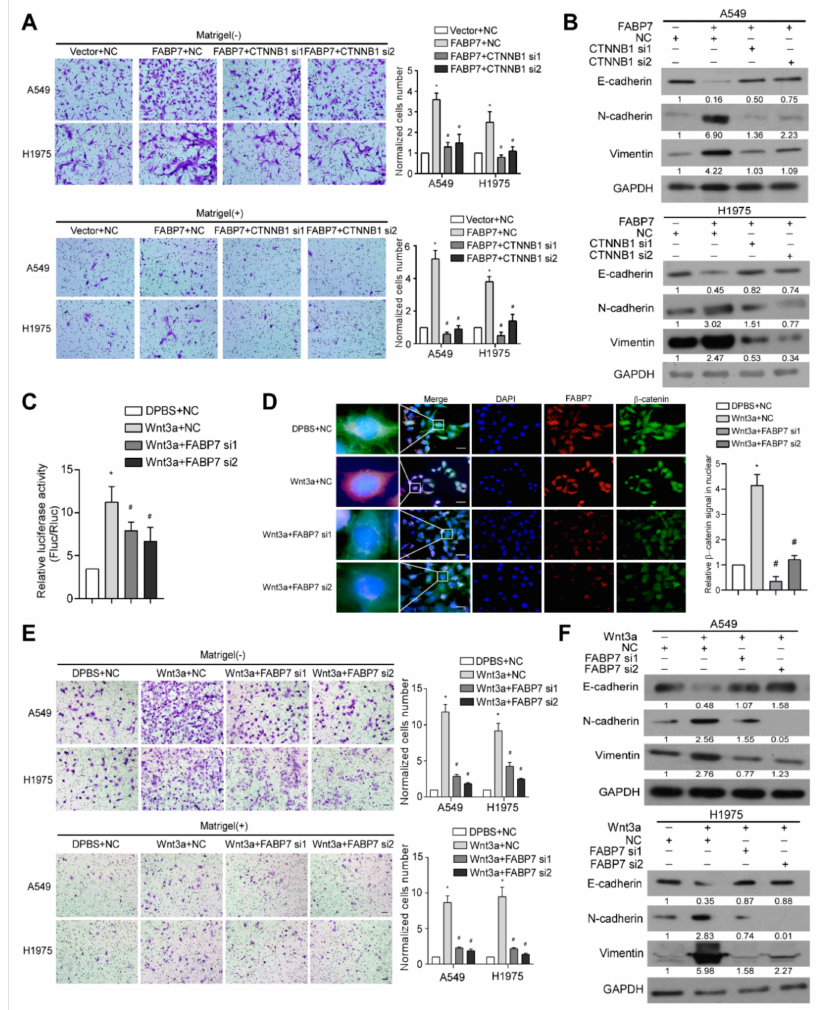
Figure 4. FABP7 is important for the activation of Wnt/ β -catenin signaling. ( A ) Tanswell assays were performed in indicated NSCLC cells. Representative images from three independent exper- iments (left) are shown. Migratory or invasive cells were quantified in five random fields. Scale bar: 50 µ m. *: p < 0.05 vs. vector + negative control (NC), #: p < 0.05 vs. FABP7+NC. ( B ) Western blot analyses of EMT markers in indicated NSCLC cells. Representative images from three indepen- dent experiments are shown. ( C , D ) Results of relative luciferase assays ( C ) and representative IF images (insets: high-magnification images) from three independent experiments ( D ) in H1975 cells. *: p < 0.05 vs. vehicle+NC, #: p < 0.05 vs. Wnt3a+NC. Scale bar: 10 µ m. ( E ) Tanswell assays were performed in indicated NSCLC cells. Representative images are from five random fields of transwell assay. Migratory or invasive cells were quantified in five random fields. Scale bar: 50 µ m. *: p < 0.05 vs. vehicle+NC, #: p < 0.05 vs. Wnt3a+NC. ( F ) Western blot analyses on EMT markers in indicated NSCLC cells. Representative images are shown from three independent experiments. All error bars represent the mean ± SD derived from three independent experiments, and statistical analyses were performed by two-sided Mann-Whitney